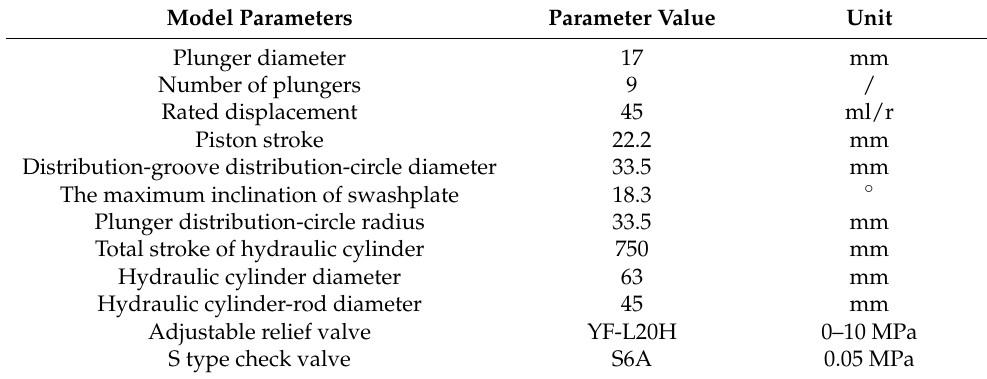
Table 1. Parameters used in